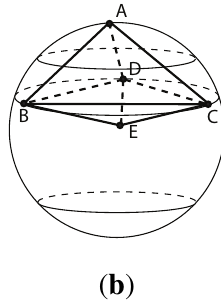
Illustration of a Delaunay unit tetrahedron cell (DUTC), under an